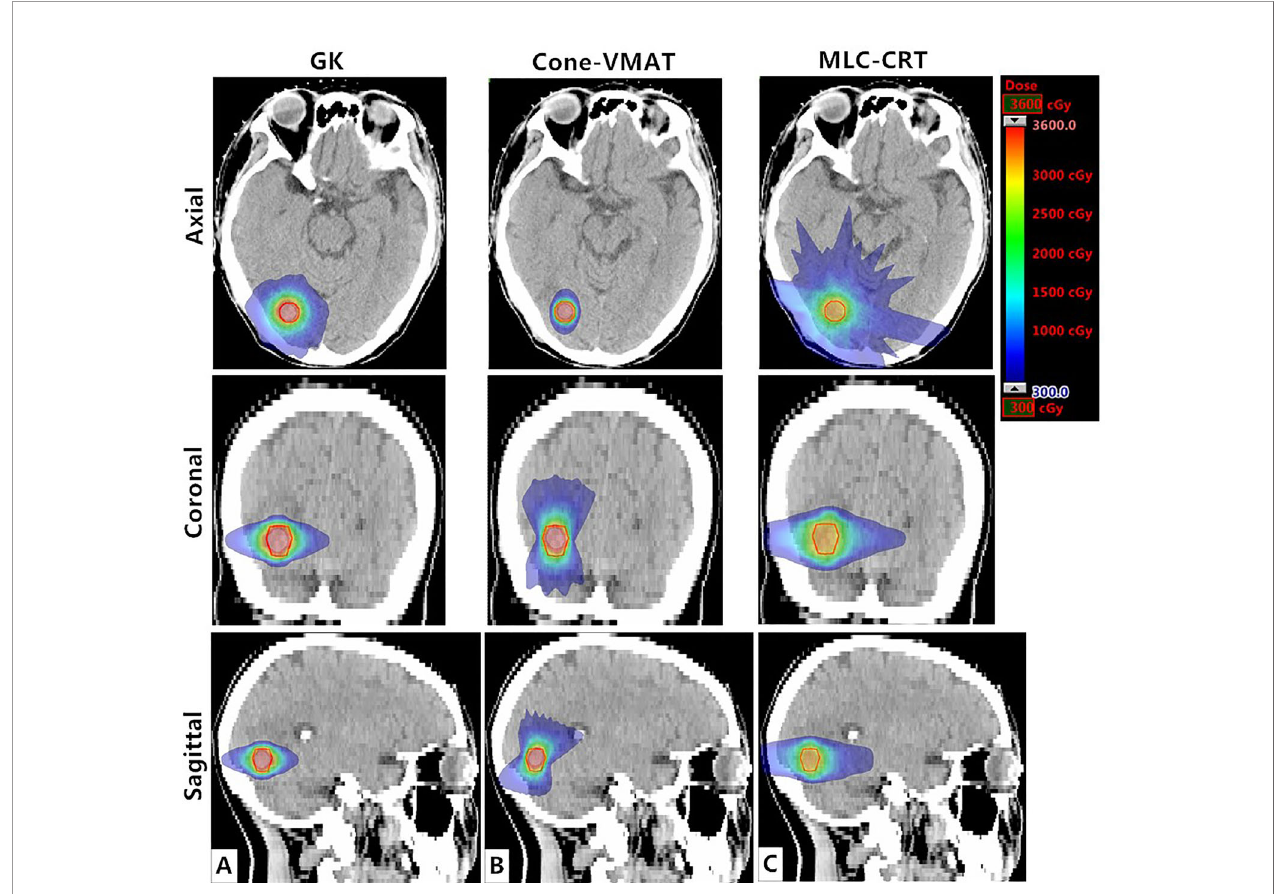
FIGURE 1 | Axial, coronal, and sagittal cuts at the target center of the example case to visually demonstrate differences in dose distribution among (A) GK, (B) Cone-VMAT, and (C) MLC-CRT SRS plans. The solid red line represents